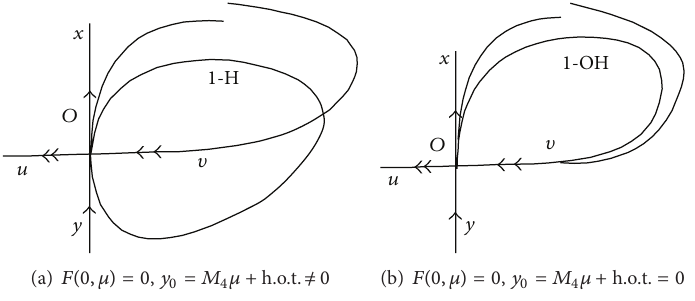
Figure 3: 1-homoclinic orbit (1-H) and